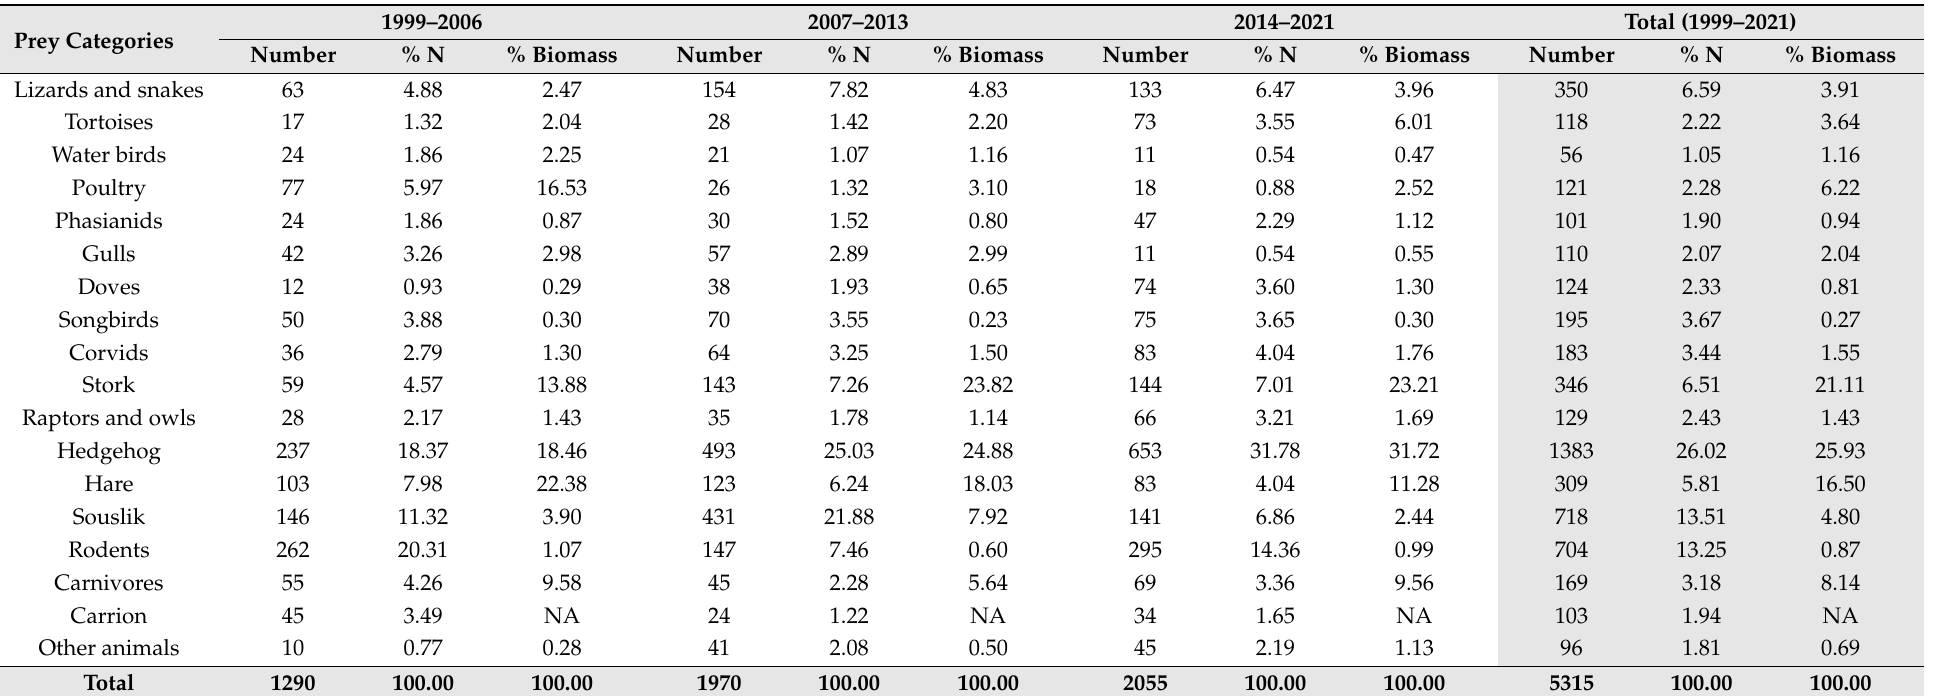
Table 4. Proportion of different eastern imperial eagle prey categories in Bulgaria in the three studied